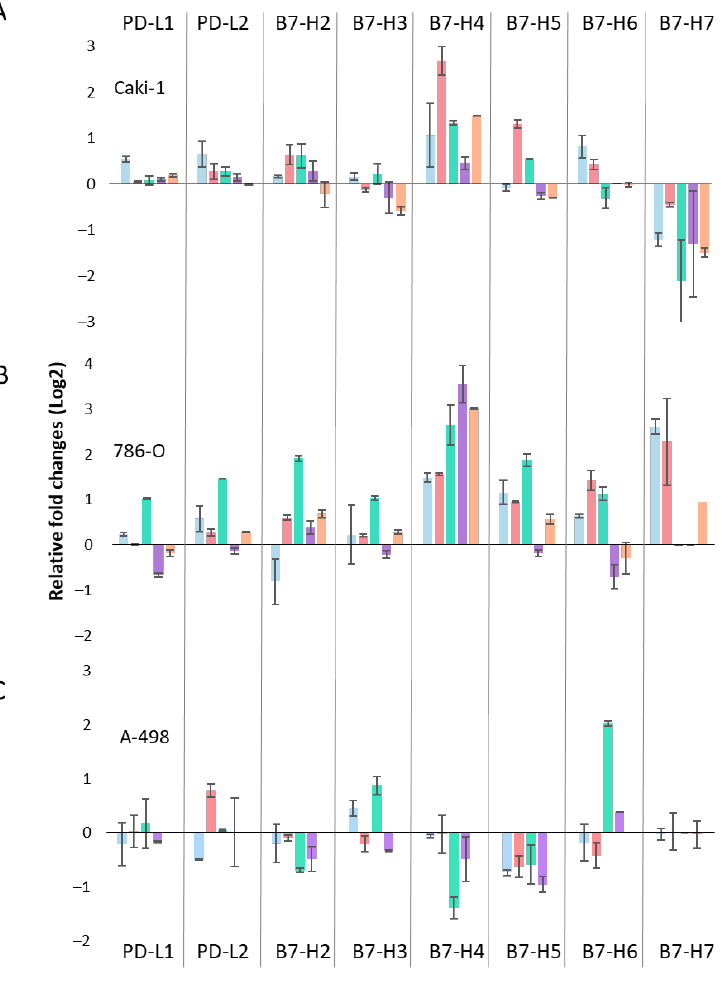
Figure 2. B7 family gene expression upon treatment with tyrosine kinase inhibitors or with mTOR inhibitors. B7 family gene expression in Caki-1 ( A ), 786-O ( B ), and A-498 ( C ) cells upon